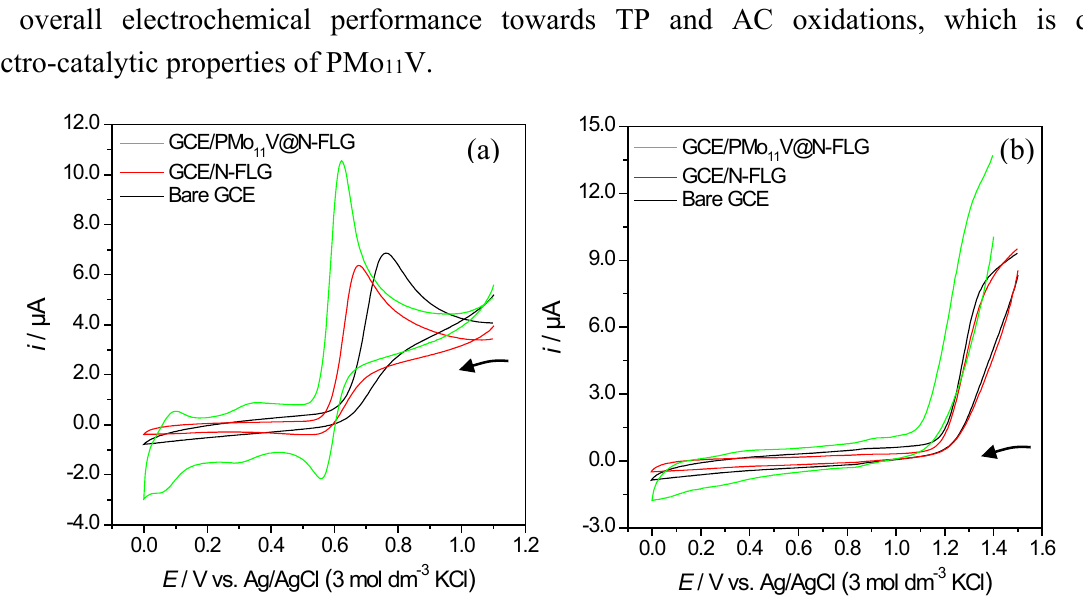
Figure 4. Cyclic voltammograms of 5.0 × 10 − 4 mol dm − 3 AC ( a ) and TP ( b ) at a bare GCE, N-FLG/GCE and PMo 11 V@N-FLG/GCE in pH 2.5 H 2 SO 4 /Na 2 SO 4 buffer solution, scan rate 0.050 V s − 1